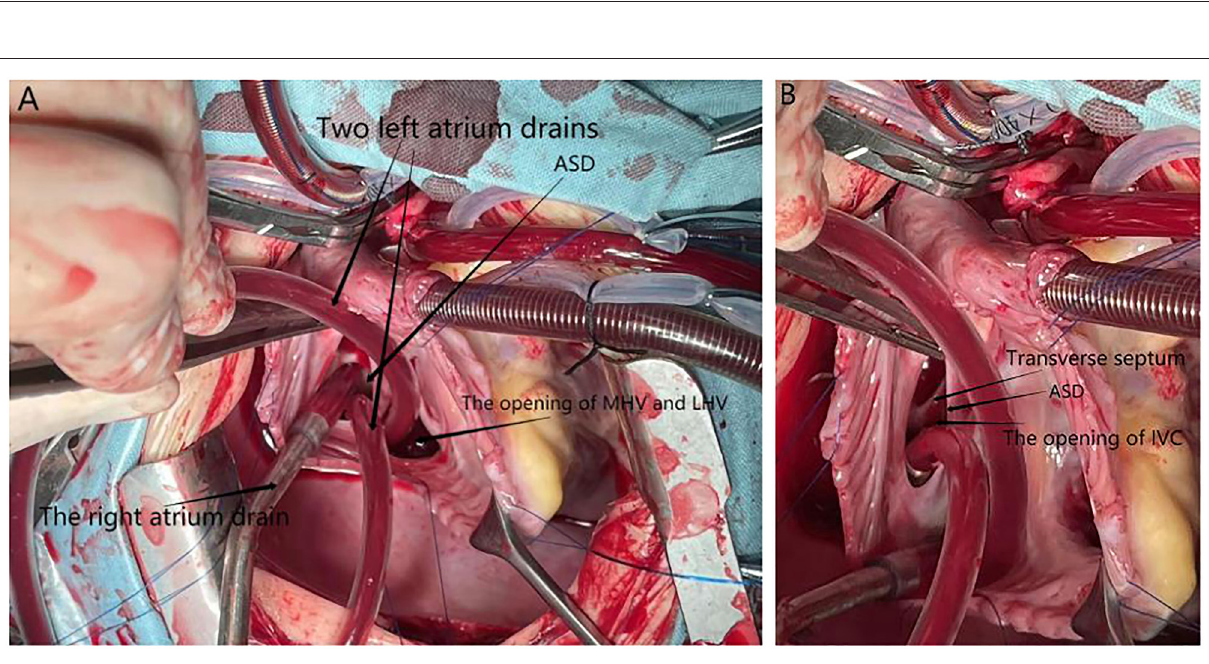
FIGURE 2 | 3D reconstruction and 3D printing. (A) Three large atrial septal defects (one of fossa ovalis type [diameter of 6mm], one near the superior vena cava [diameter of 15mm], and one near the inferior vena cava [diameter of 8mm]); the left hepatic vein joined the middle hepatic vein, and the opening was located in the right atrium. (B,C) The right hepatic vein drained into the inferior vena cava, and the opening of the inferior vena cava was located in the left atrium. (D) Two atrial septal defects were visible from the right atrium incision level.